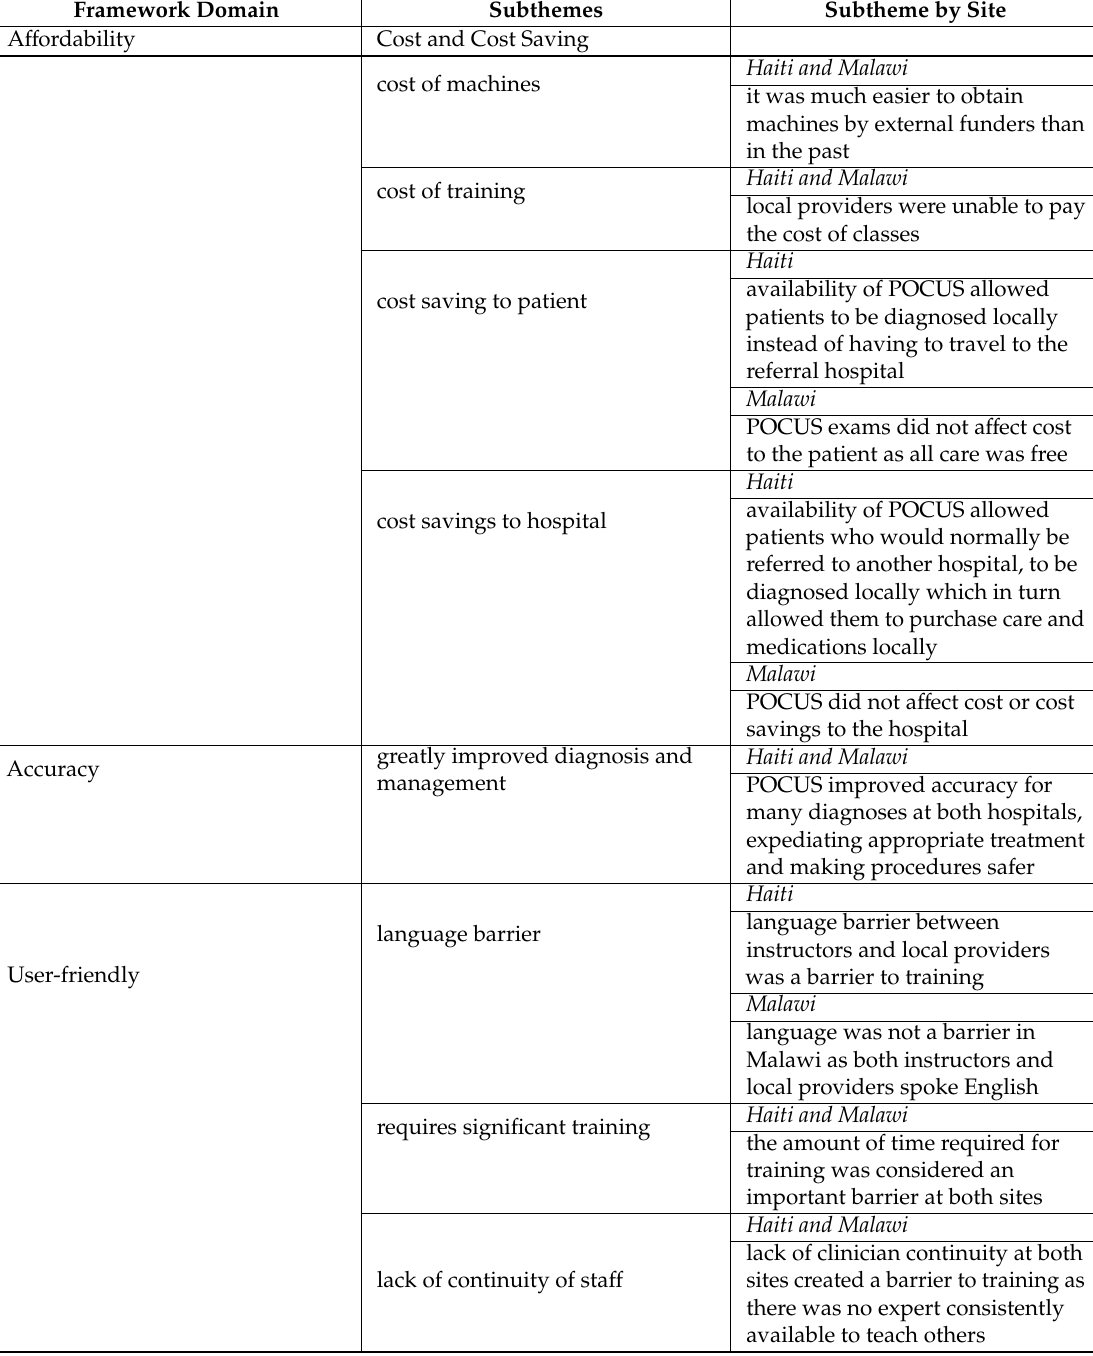
Table 3. Themes identified from interview